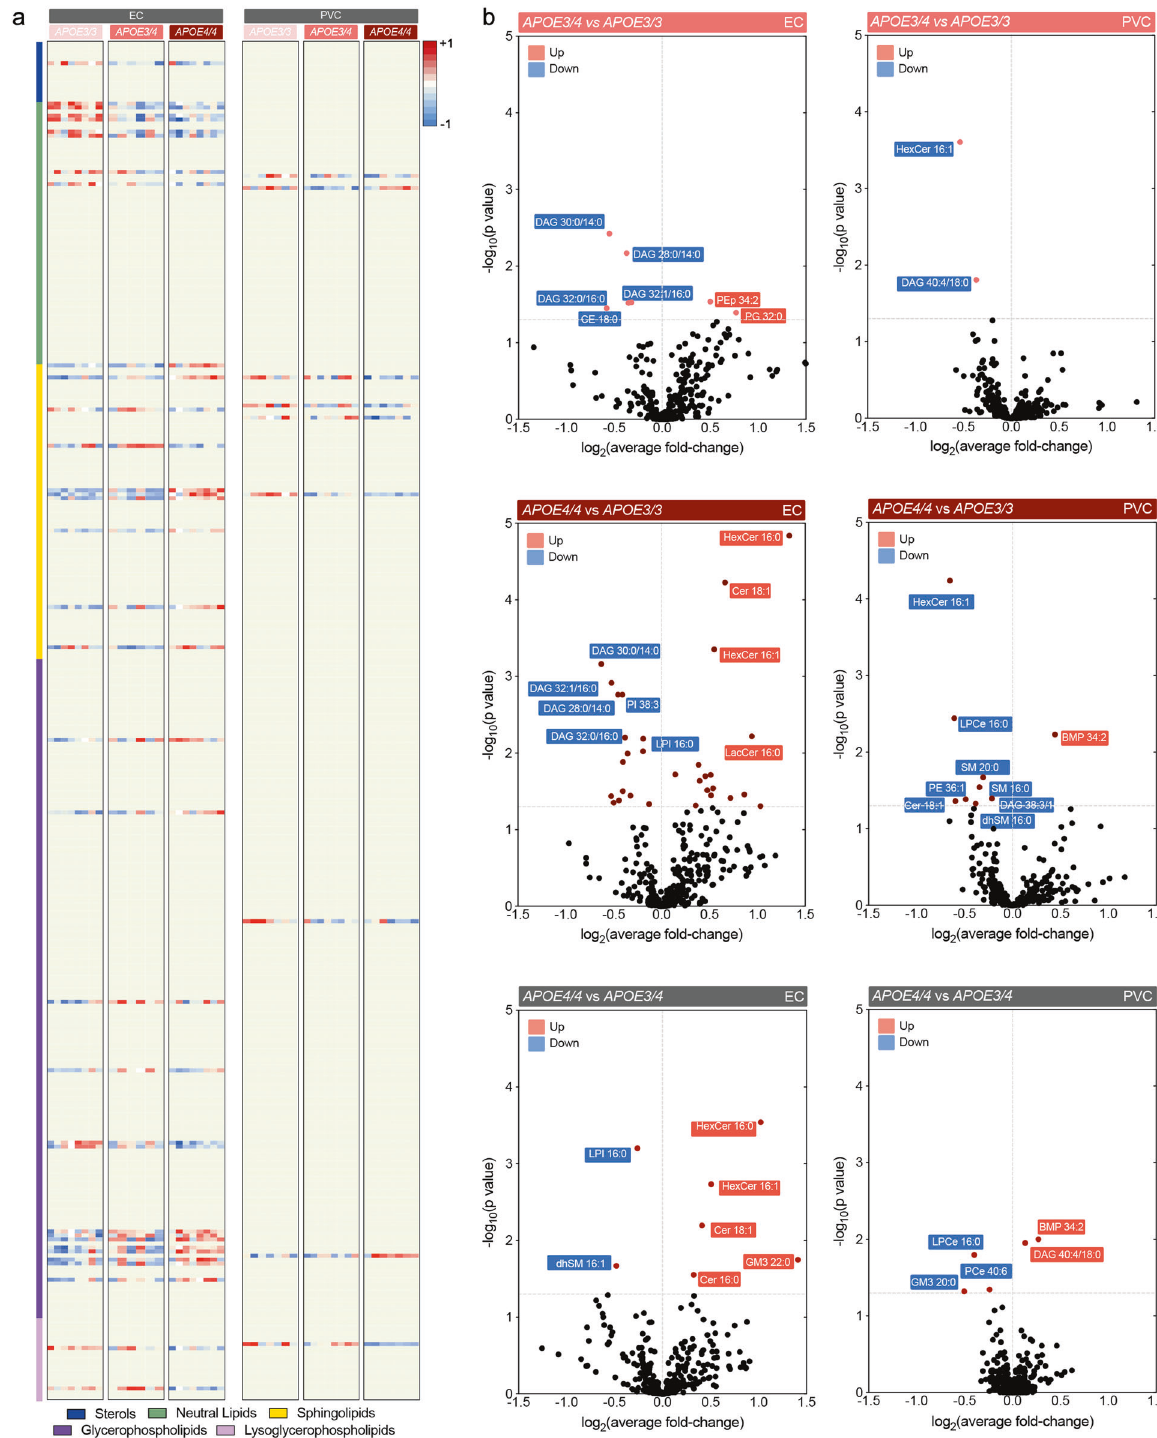
Fig. 1 Comparative lipid pro fi le of EC and PVC of aged APOE targeted replacement mice. a Heatmap of lipids signi fi cantly altered by APOE3/4 , APOE4/4 and APOE3/3 genotype in EC and PVC at 14 – 15 months of age. Each row represents a lipid species of a given category (see color legends); each column represents a sample. Results are expressed as Z-score [(average mol% of lipid species per genotype − average mol % of lipid species in all genotypes)/standard deviation of average mol% lipid species] represented in gradient color; blue and red indicate negative and positive Z-score, respectively. One-way ANOVA was performed and results thresholded by p < 0.05; n = 8, 6, and 8 for EC and n = 7, 8, and 7 for PVC in APOE3/3 , APOE3/4 , and APOE4/4 mice, respectively. b , c Volcano plots of differentially modulated lipid species in EC and PVC between APOE3/4 vs. APOE3 / 3 , APOE4/4 vs. APOE3 / 3 and APOE4 / 4 vs. APOE3 / 4 . Colored plots denote signi fi cantly affected species at Tukey ’ s post-hoc p < 0.05, black plots denote unaltered species ( p >